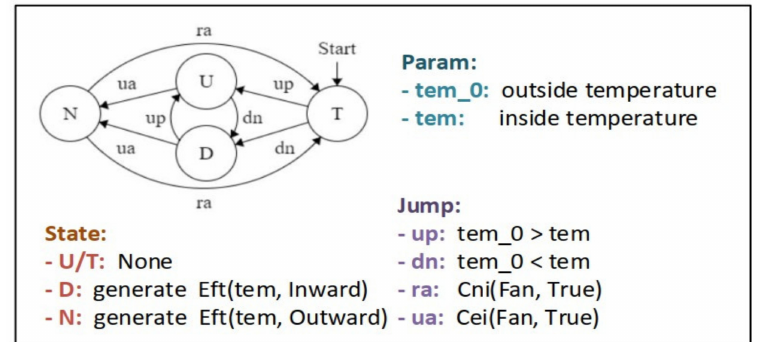
Figure 4. Example of bottom EPA with boundary condition triggering jump (EPA1).